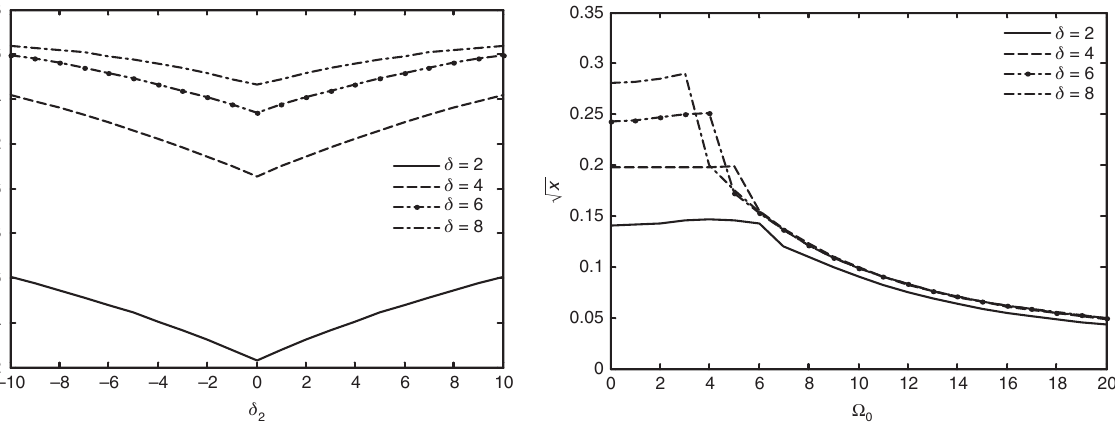
Figure 11: Variations of non-dimensional phase speed ( ) x against impedance parameter δ